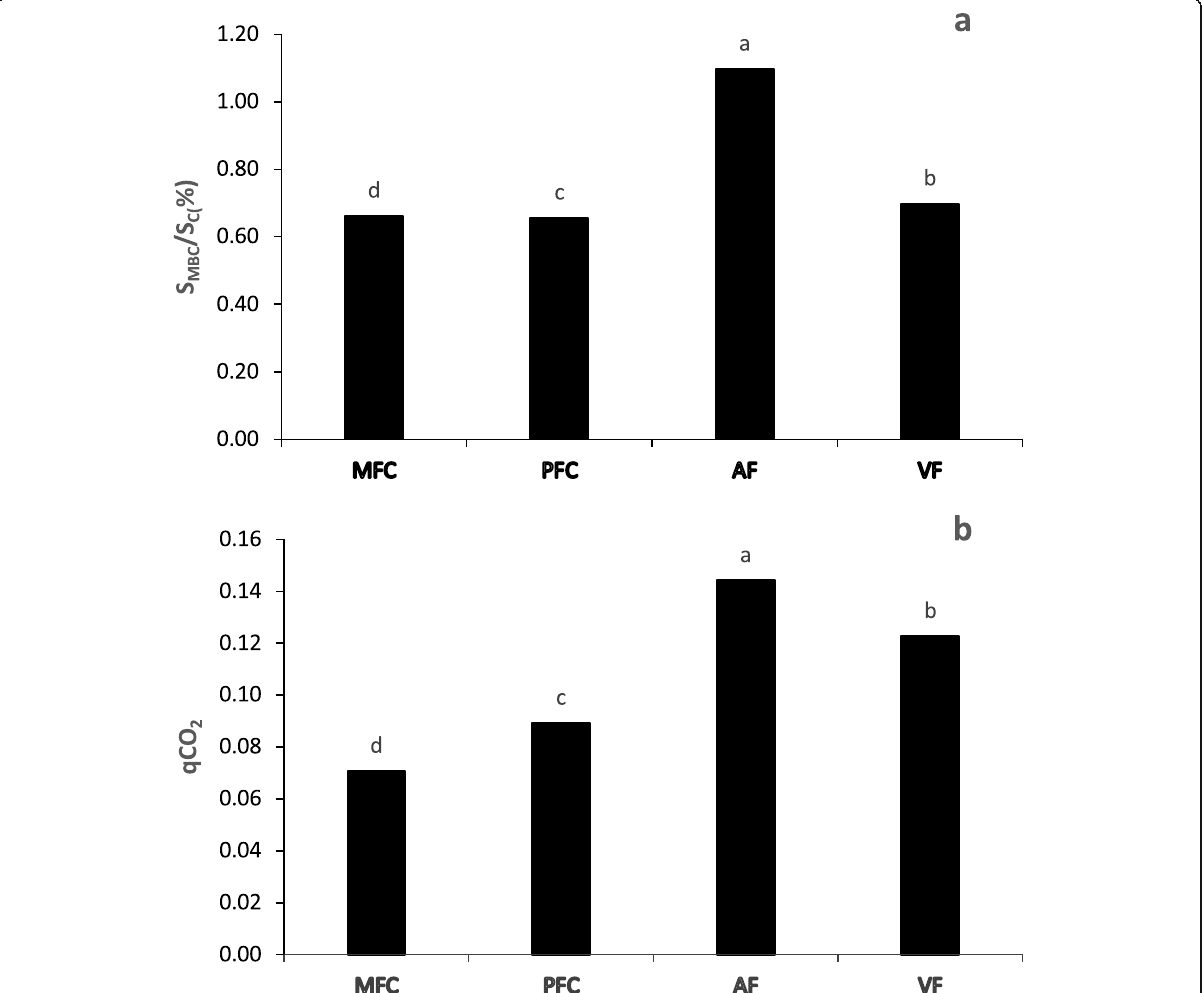
Fig. 2 S MBC /S C ( a ) and qCO 2 ( b ) under different land uses. Mean values with different letters are significantly different between land uses ( P < 0.05). Note: